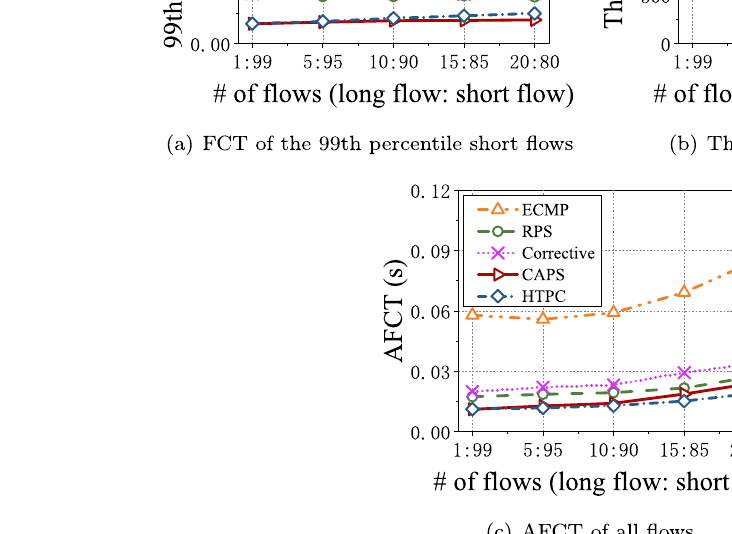
Fig. 8 Performance under different flow proportions